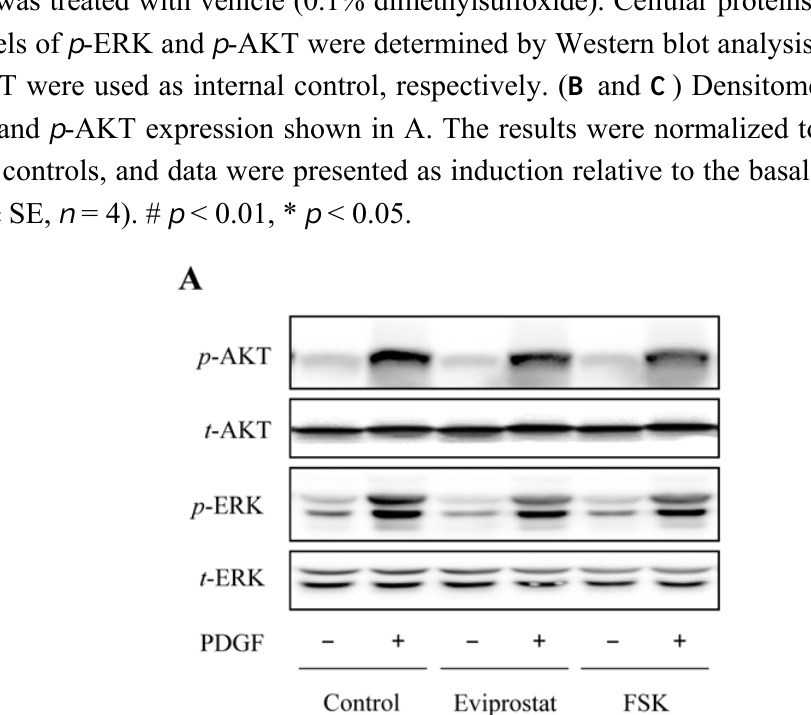
Figure 5. Interference of PI3K and MAPK activation by Eviprostat. ( A ) Inhibition